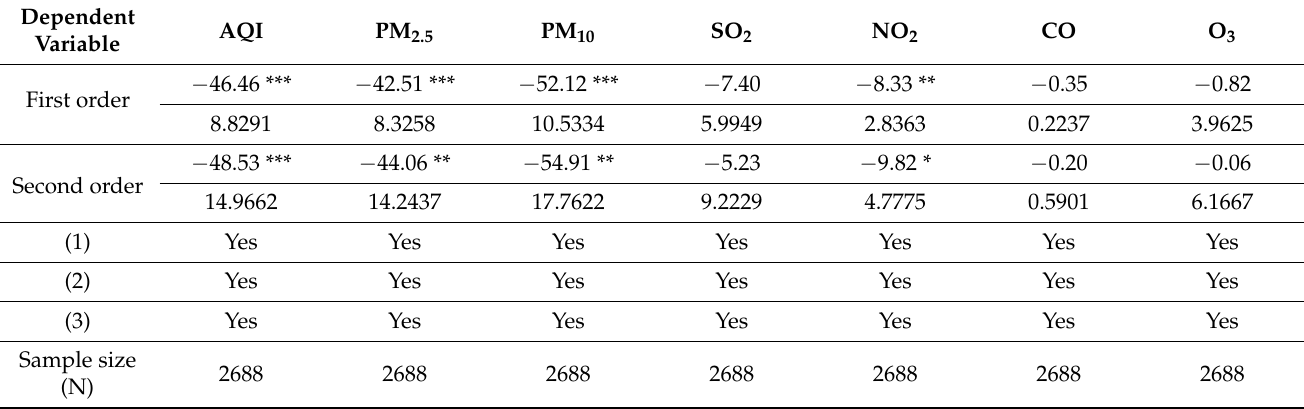
Table 4. Regression discontinuity (RD) estimation results of full sample daily